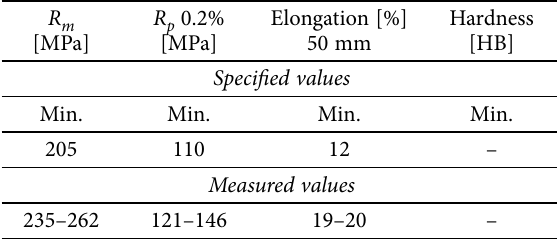
Table 3. The final requirements for connecting